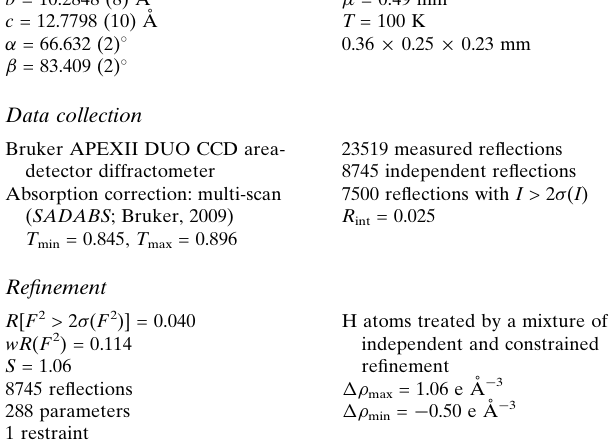
23519 measured reflections 8745 independent reflections 7500 reflections with I > 2 (cid:2) ( I ) R int = 0.025 H atoms treated by a mixture of independent and constrained refinement (cid:2) (cid:8) max = 1.06 e A˚ (cid:4) 3